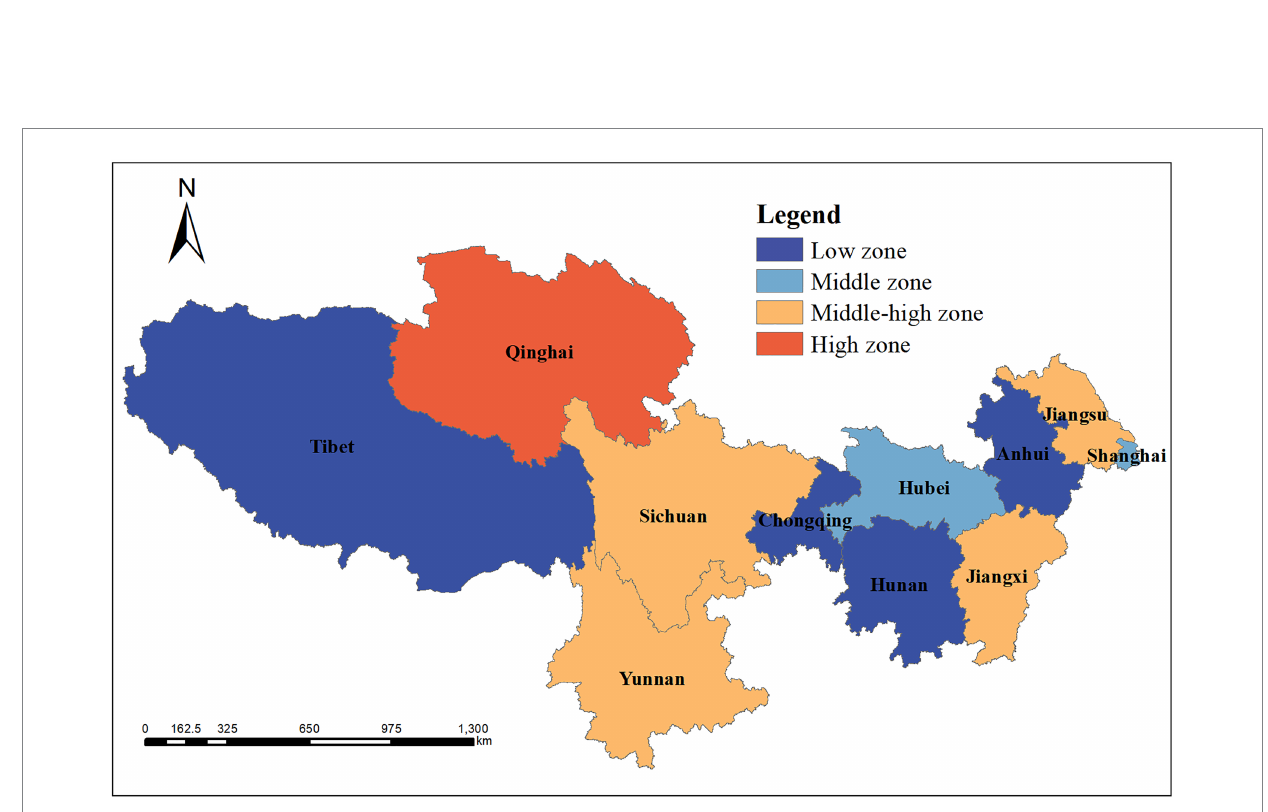
FIGURE 9 Dynamic changes of ecological environment pressure in the Yangtze River